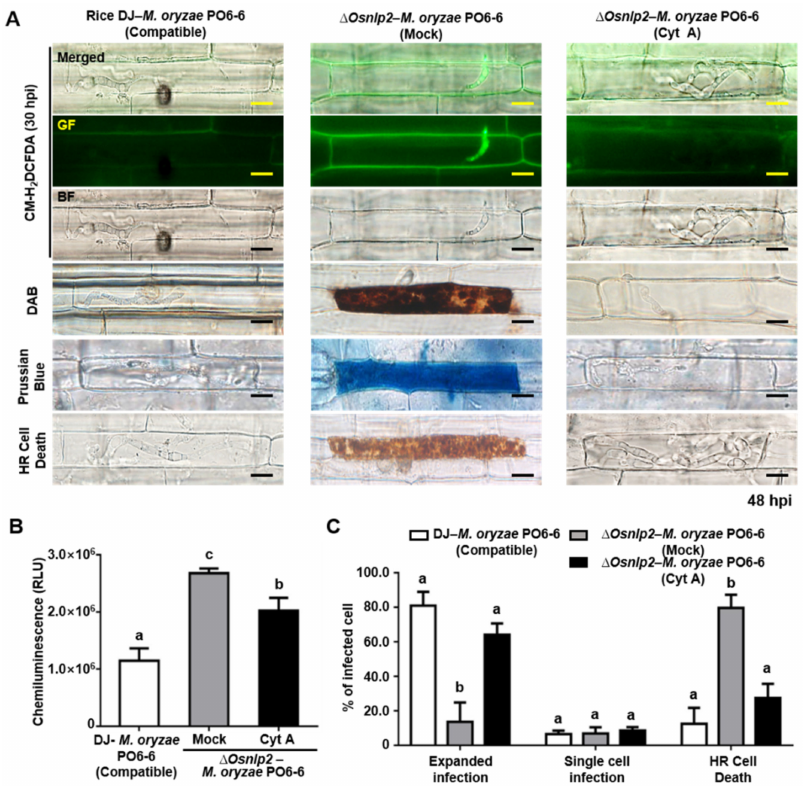
Figure 6. The actin filament inhibitor cytochalasin A (Cyt A) suppresses the accumulation of ROS and ferric ions and HR cell death in ∆ Osnlp2 leaf sheaths infected with virulent Magnaporthe oryzae PO6-6. ( A ) Inhibition of ROS and ferric ion accumulation and HR cell death in infected rice cells treated with 20 µ g mL − 1 Cyt A. Leaf sheaths of rice DJ and ∆ Osnlp2 mutant line #4-2 were inoculated with M. oryzae PO6-6. ROS accumulation was detected by CM-H 2 DCFDA and DAB staining, and ferric ion (Fe 3+ ) accumulation was visualized by Prussian blue staining. The images were taken using a fluorescence microscope (Zeiss equipped with Axioplan 2) with bright field or GF filters (Ex/Em: 488 nm/505–550 nm wavelengths). BF, bright field; GF, green fluorescence; hpi, hours post